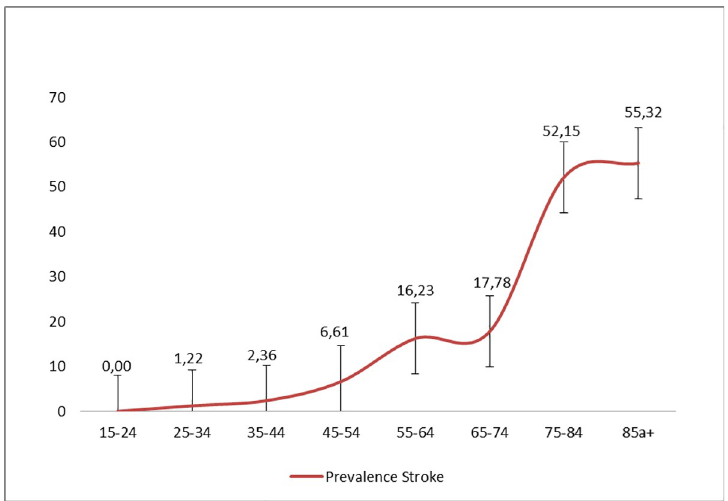
Fig 3. Prevalence of stroke and confidence interval stratified by age in 80 rural